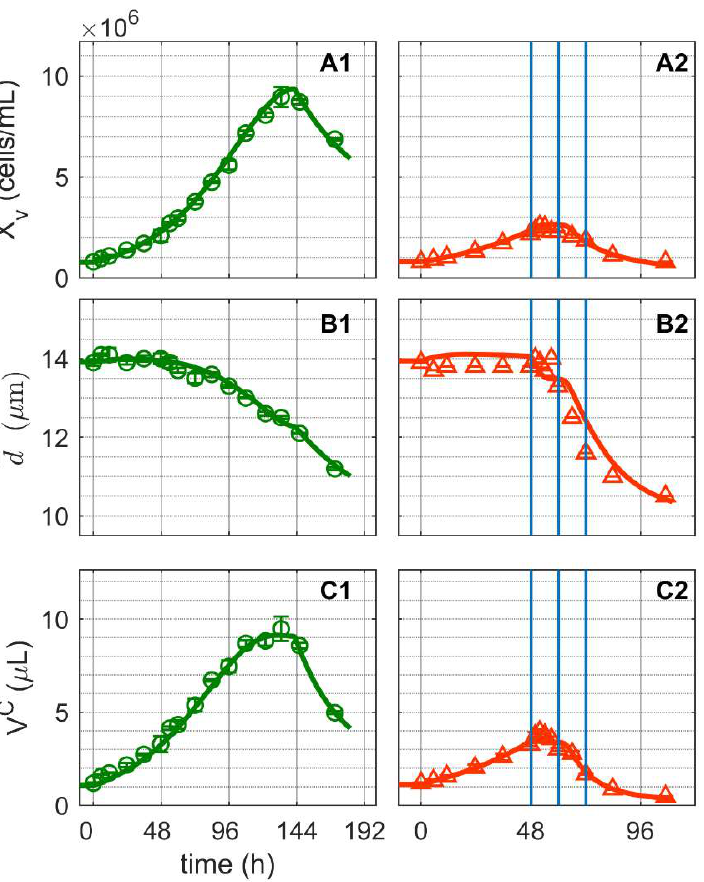
Figure 3. Dynamics of extracellular substrates and metabolic by-products in mock-infected and in- Figure 1. Dynamics of cell growth in mock-infected and infected suspension MDCK cells. ( A1 , A2 ) Figure 1. Dynamics of cell growth in mock-infected and infected suspension MDCK cells . ( A 1, A 2) fected suspension MDCK cells. ( A 1, A 2) Glucose, ( B 1, B 2) lactate, ( C 1, C 2) glutamine, ( D 1, D 2) Figure 1. Dynamics of cell growth in mock-infected and infected suspension MDCK cells . ( A 1, A 2) Viable cell concentration, ( B1 , B2 ) mean cell diameter and ( C1 , C2 ) total volume of viable cells. Data Viable cell concentration, ( B 1, B 2) mean cell diameter and ( C 1, C 2) total volume of viable cells. Data ammonium, ( E 1, E 2) pyruvate, and ( F 1, F 2) glutamate. Data and error bars represent the mean and Viable cell concentration, ( B 1, B 2) mean cell diameter and ( C 1, C 2) total volume of viable cells. Data and error bars represent the mean and standard deviation of technical triplicates for two independent and error bars represent the mean and standard deviation of technical triplicates for two independ- standard deviation of technical triplicates for two independent experiments (mock-infected Θ and and error bars represent the mean and standard deviation of technical triplicates for two independ- ent experiments (mock-infected Θ and infected ∆). Lines: model simulations. Vertical blue lines cor- infected ∆). Lines: model simulations. Vertical blue lines correspond to 0, 12 and 24 h post infection, experiments (mock-infected and infected ). Lines: model simulations. Vertical blue lines corre- ent experiments (mock-infected Θ and infected ∆). Lines: model simulations. Vertical blue lines cor- respond to 0, 12 and 24 h post infection. Experimental data used for parameter estimation: A 1, B 1, respectively. The grey dashed lines indicate the limit of quantification for each metabolite and grey spond to 0, 12 and 24 h post infection. Experimental data used for parameter estimation: A1 , B1 , C1 respond to 0, 12 and 24 h post infection. Experimental data used for parameter estimation: A 1, B 1, C 1 (see Supplementary File S4 and S5). data points are under the limit of quantification. Experimental data used for parameter estimation: (see Supplementary Files S4 and C 1 (see Supplementary File S4 and S5). A 1, B 1, C 1, D 1, E 1 and F 1 (see Supplementary File S4 and S5). The concentration of extracellular lactate (Figure 3B) increased in the bioreactor until glucose was depleted. As previously reported for MDCK cells [57,58], the stoichiometric ratio of lactate to glucose was approximately 1:1 for both cultivations. Typically, in con- tinuous cell lines, the majority of glucose is converted to pyruvate via glycolytic enzymes, which in turn is converted to lactate to regenerate NAD + to maintain a high ATP genera- tion rate [59,60]. The previous model used lumped reaction to describe extracellular lac- tate production directly from intracellular pyruvate [52]. However, in this study, to better describe the extracellular lactate dynamics, lactate metabolism had to be considered in